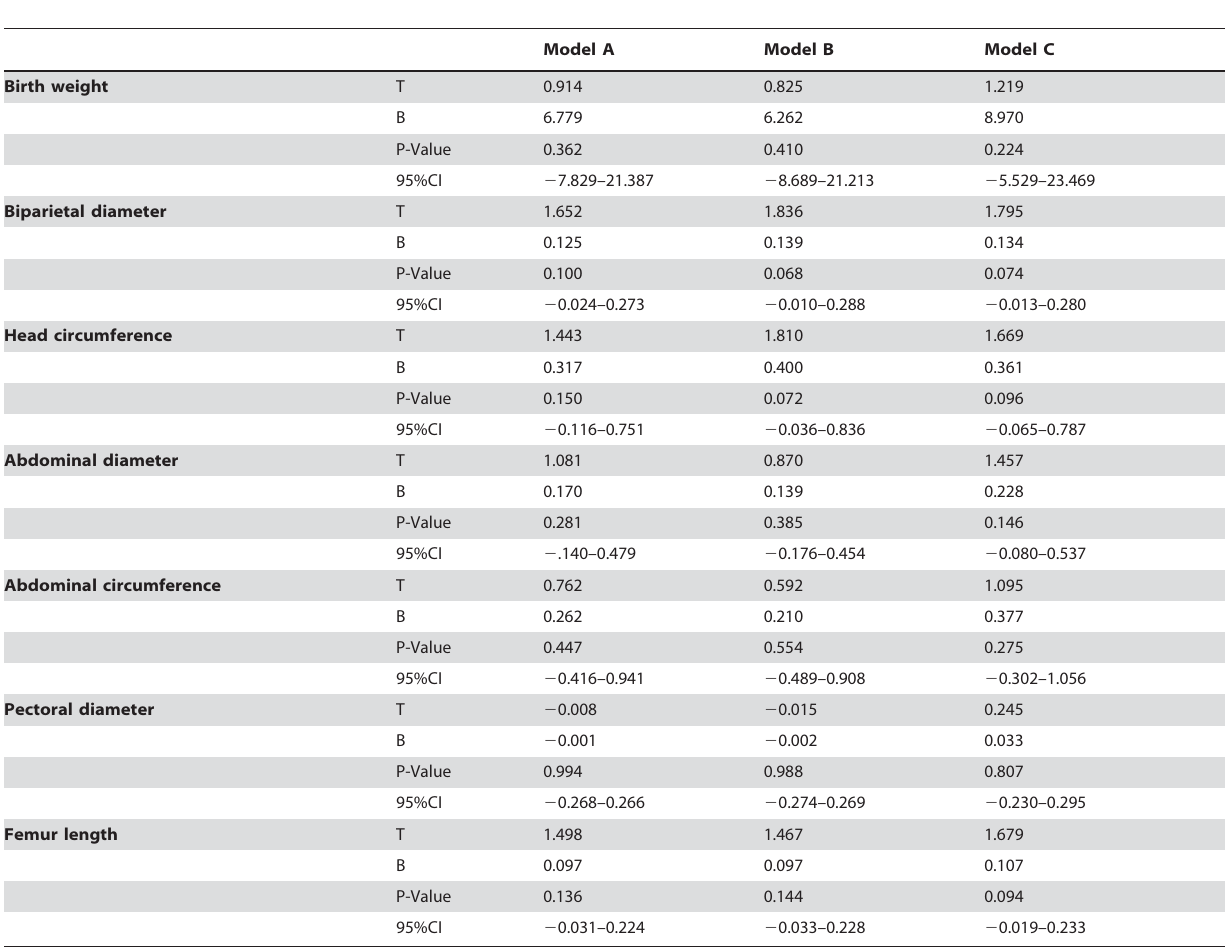
Table 4. Multivariable regression analysis of the association between ultrasound measurements in late gestation or birth weight and paternal BMI in newborn